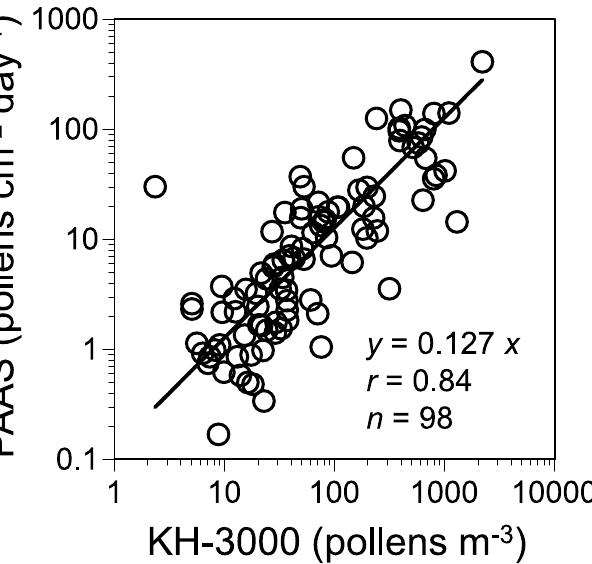
Fig 2. Relationship between the PAAS and KH-3000. The outdoor pollen counts by the PAAS in Isehara are compared with the ambient concentrations by the KH-3000 at the Atsugi station. The pollen counts by the PAAS are averaged for all subjects. The hourly pollen concentrations by the KH-3000 are averaged for the corresponding sampling durations by the PAAS. Linear regression through the origin is used as the intercept is not significantly different from